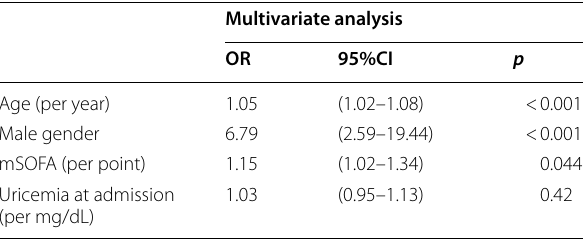
mSOFA modified Sequential Organ Failure